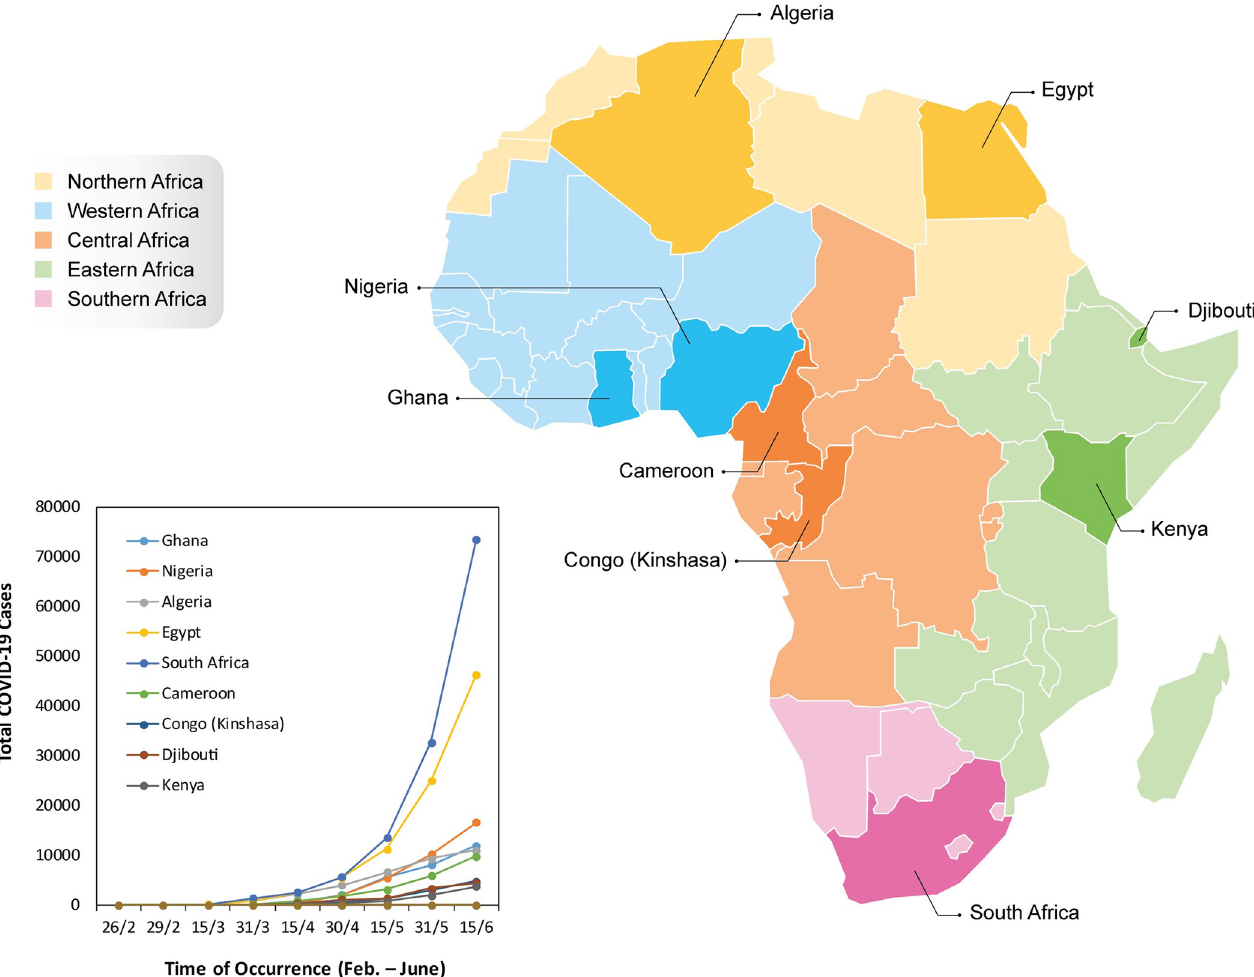
Fig 1. Epidemiological characteristics of COVID-19 in Africa. Cumulative cases of COVID-19 in Africa. Countries indicated on the map represent those with highest number of cases in each five regions (West, East, Central, Southern and North Africa) as of June 15, 2020. Highlighted countries represent countries with highest number of cases in the five regions at the early phase of COVID-19 in Africa. The figure contains information from OpenStreetMap and OpenStreetMap Foundation, which is made available under the Open Database License .